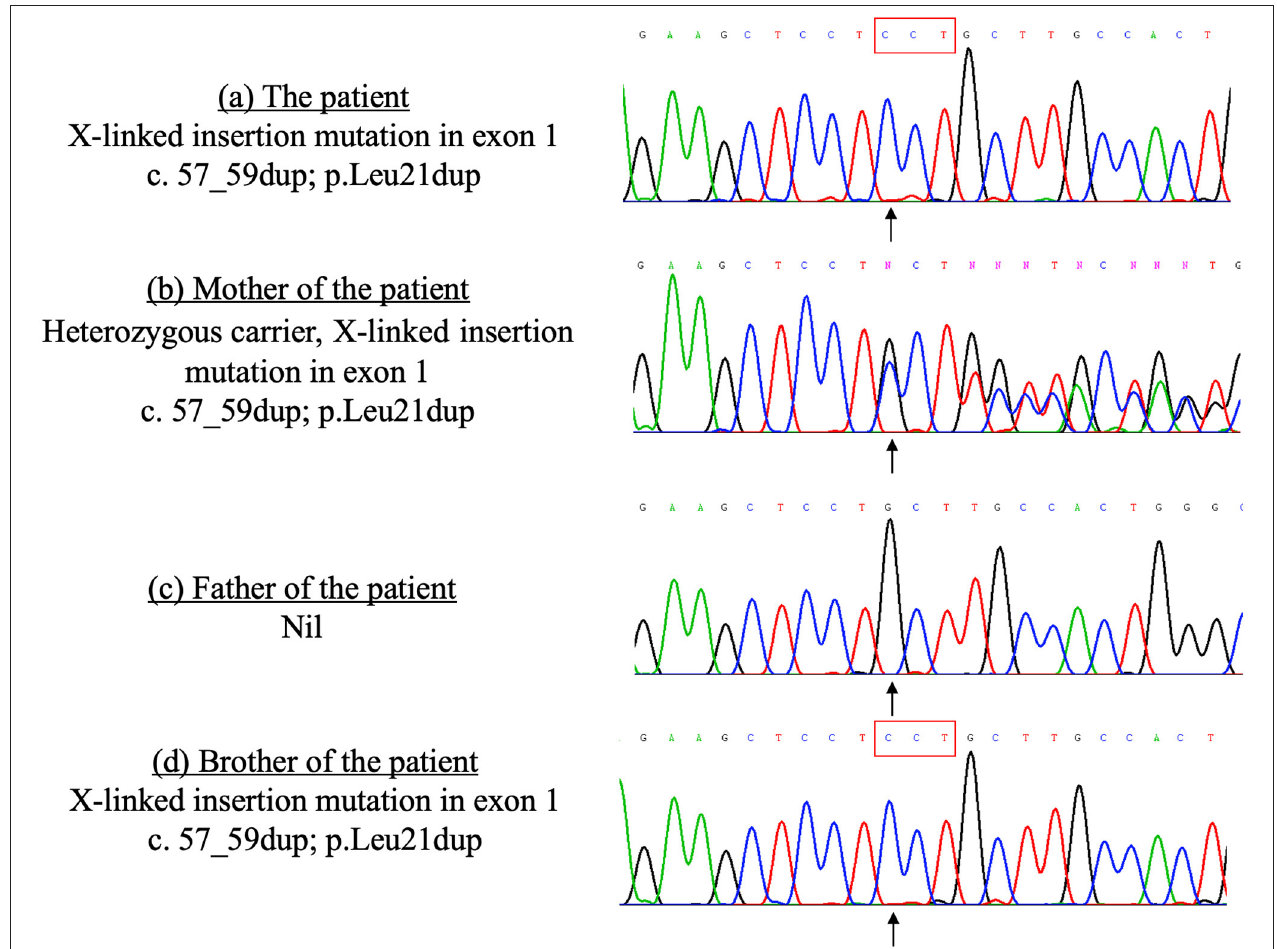
FIGURE 2 | Sanger sequencing of the SH2D1A gene of the patient and his family members done in 2010. The patient and his brother carry the same X-linked mutation in the exon 1 of the SH2D1A gene, which was inherited from their mother. (a) The patient X-linked insertion mutation in exon 1c.57_59dup; p.Leu21dup. (b) Mother of the patient Heterozygous carrier, X-linked insertion mutation in exon 1c.57_59dup; p.Leu21dup. (c) Father of the patient Nil. (d) Brother of the patient X-linked insertion mutation in exon 1c.57_59dup;